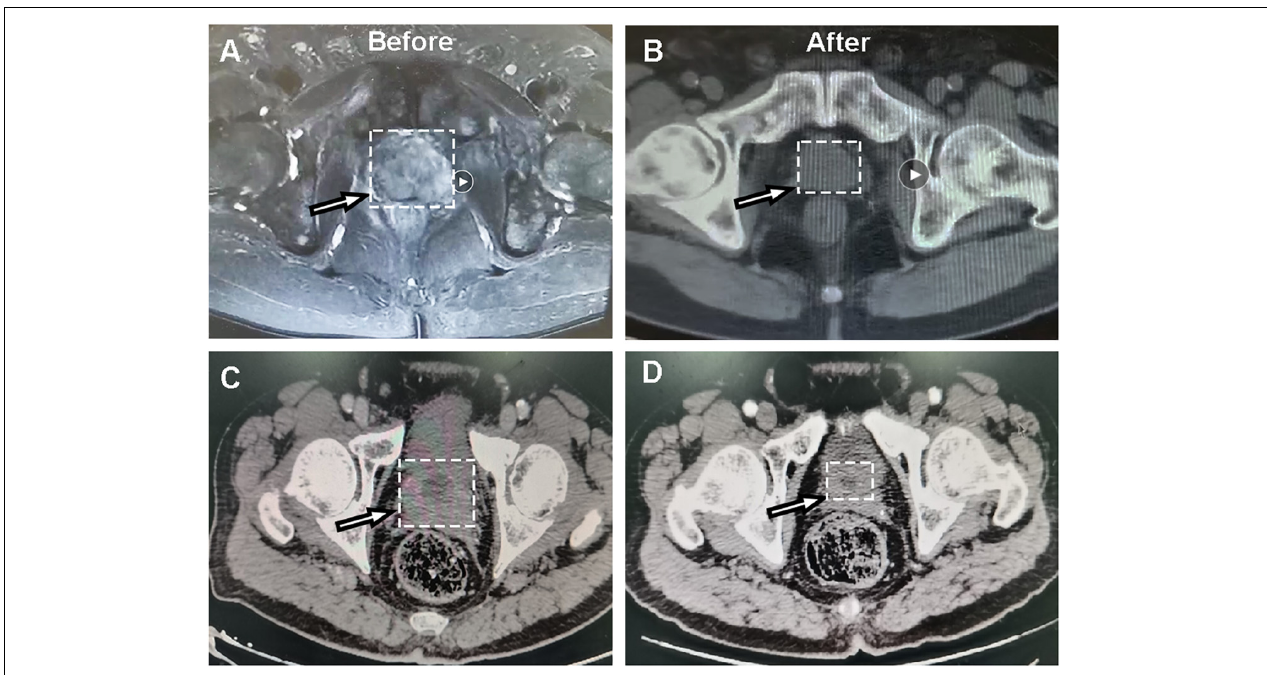
FIGURE 1 | Representative CT images of dicycloplatin-sensitive patients. (A,B) CT images of one patient with complete response taken before (A) and after (B) dicycloplatin treatment. (C,D) CT images of another patient with partial response taken before (C) and after (D) dicycloplatin treatment. White arrow represents the tumor